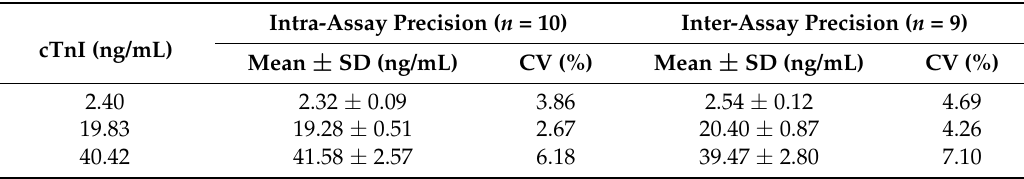
Table 3. Results of reproducibility analysis by intra-assay and inter-assay precision.